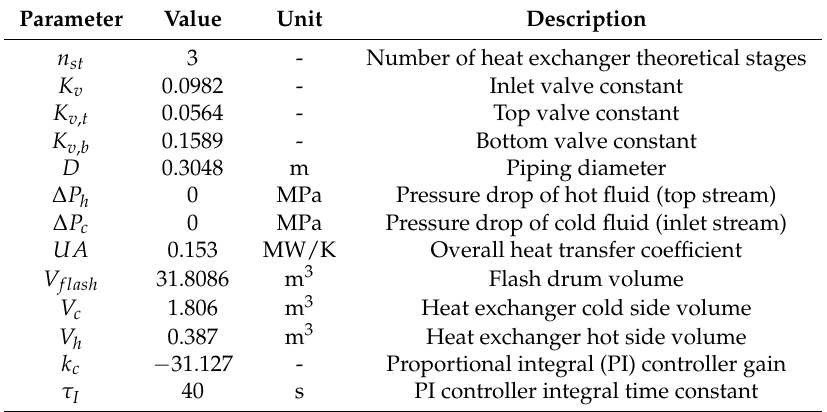
Table A1. Parameters used in the simulation.